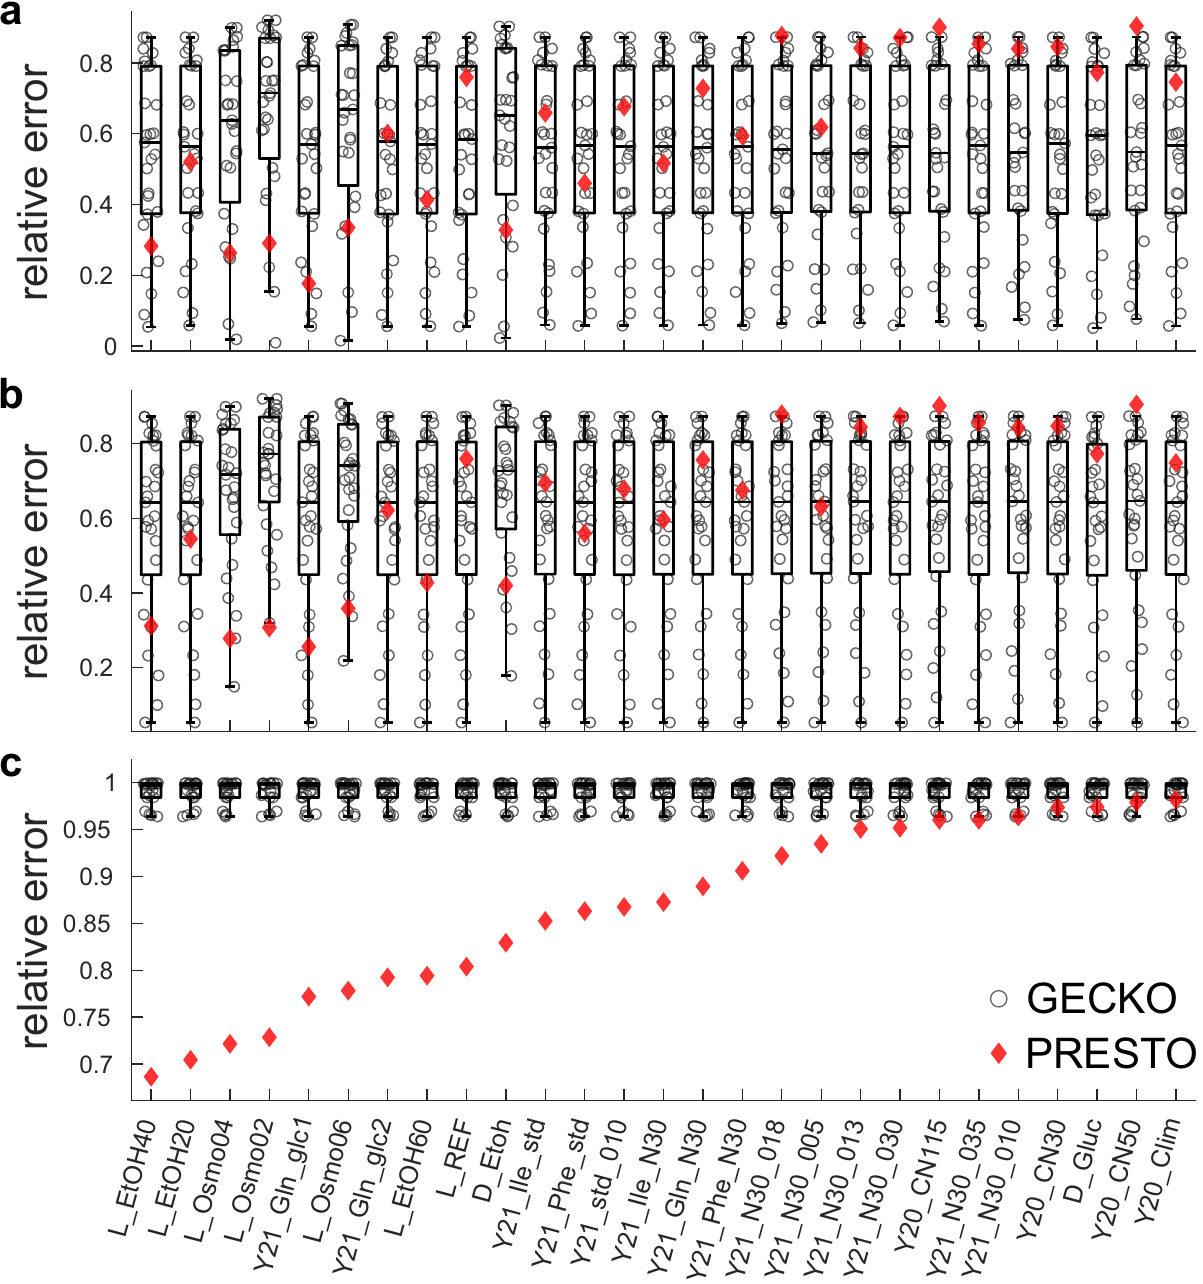
Fig. 2 | Comparison of predicted growth of S. cerevisiae from pcGEMs with k cat correctionsfromGECKOandPRESTO. Condition-speci fi cpcGEMswithcorrected k cat values generated by the GECKO heuristic were used to predict the speci growth rate foreach condition ( n =27, a , b ).The boxplots indicate the distribution of the relative error resulting from each set of condition-speci fi c corrected k cat values obtained from the GECKO heuristic. Relative prediction error from each set is indicated by a circle. The red diamonds show the relative error of the predicted speci fi c growth rate from the PRESTO model ð λ =10 (cid:1) 7 Þ by using the single set of corrected k cat values in the respective pcGEM. a Only the measured total protein pool was used to constrain the solution and condition-speci fi c uptake rates were